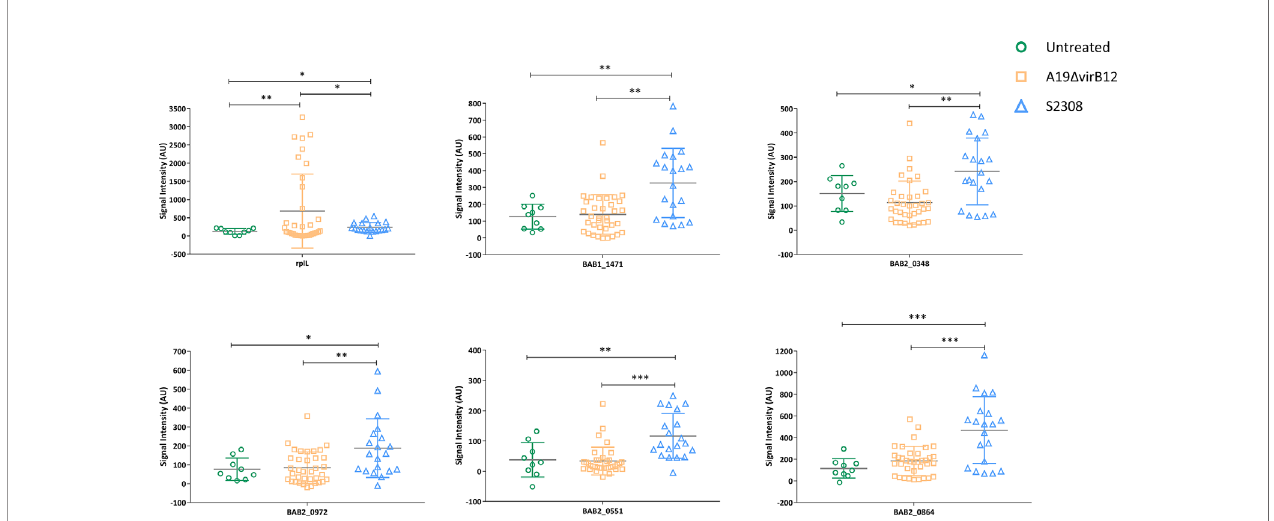
FIGURE 3 | IgG response of 5 proteins obtained from sera of cattle inoculated with A19 D virB12 or S2308. Values were expressed as the means ± (SD). Differences were determined by two-tailed Student ’ s t test (*P < 0.05; **P < 0.01; ***P <